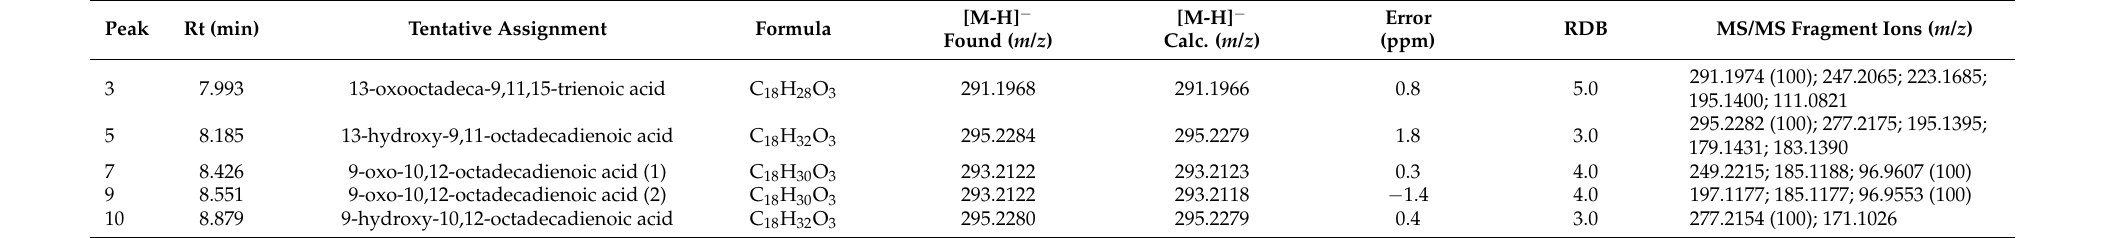
Table 2. TOF-MS and MS/MS data of oxygenated FAs tentatively identified in apolar extracts from the different Calendula arvensis organs. Peak numbers are based on elution order in the whole reversed-phase chromatograms (RDB: ring and double